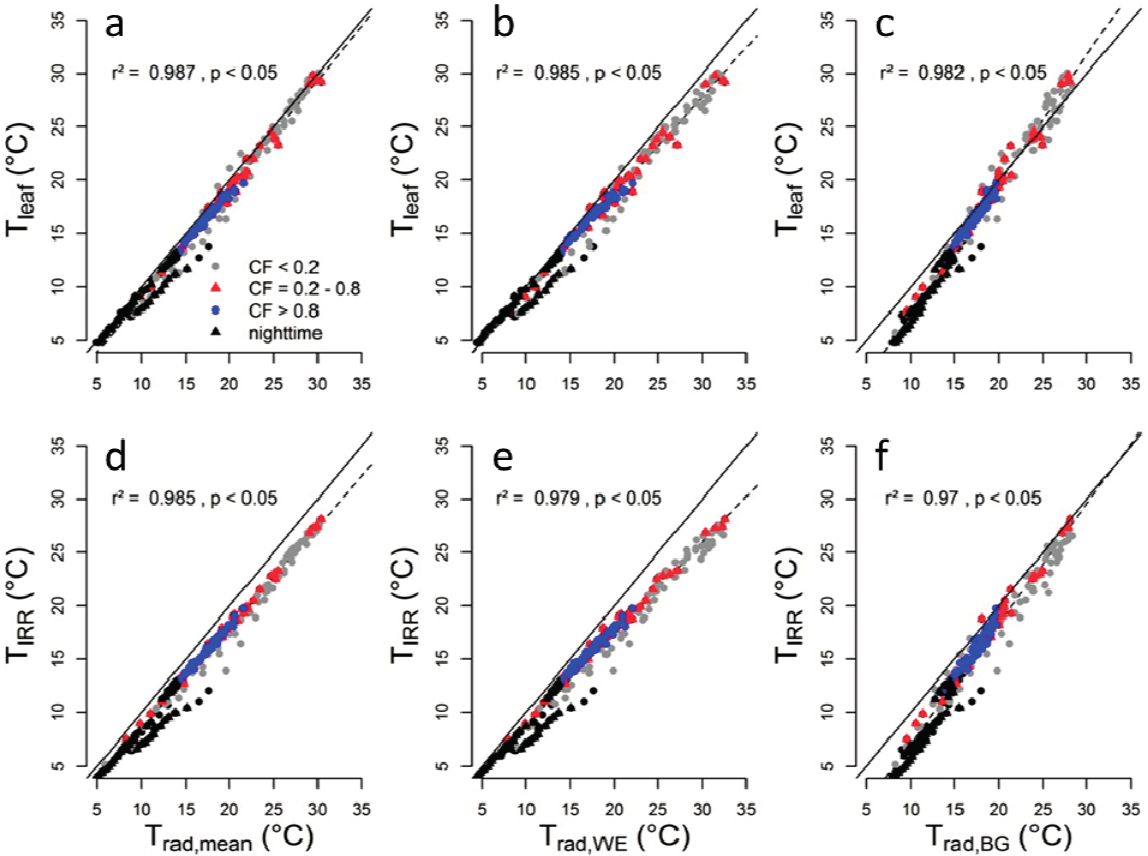
Figure 3. Linear regression fit between averaged leaf temperature recorded from thermocouples (Tleaf, Figure 3 a – c ) and between surface T recorded from an IR radiometer (TIRR, Figure 3 d – f ) with remotely sensed surface temperatures (as for Table 2). The solid line represents the line of identity, while the dashed line represents the linear regression line. CF = cloud fraction; nighttime: 21.00 h–03.00 h